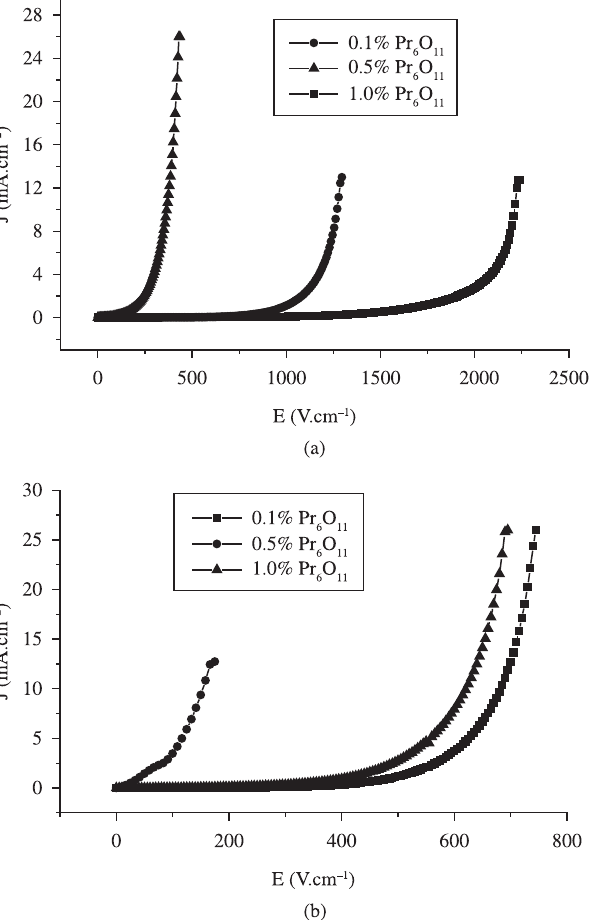
Figure 3. The current density-electric field ( J-E ) characteristics of ZPC varistors with different content of Pr